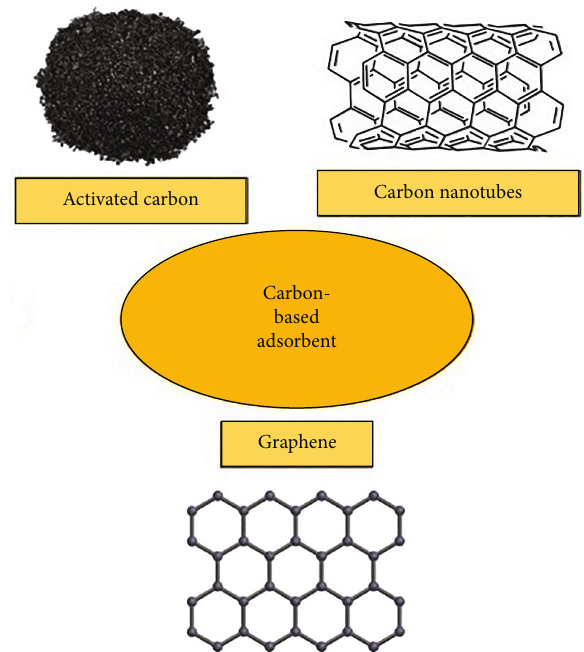
Figure 5: Carbon-based adsorbents. Activated carbon, carbon nanotubes, graphene, and their composites are common carbonaceous materials that show good adsorption capability for antibiotic pollutant